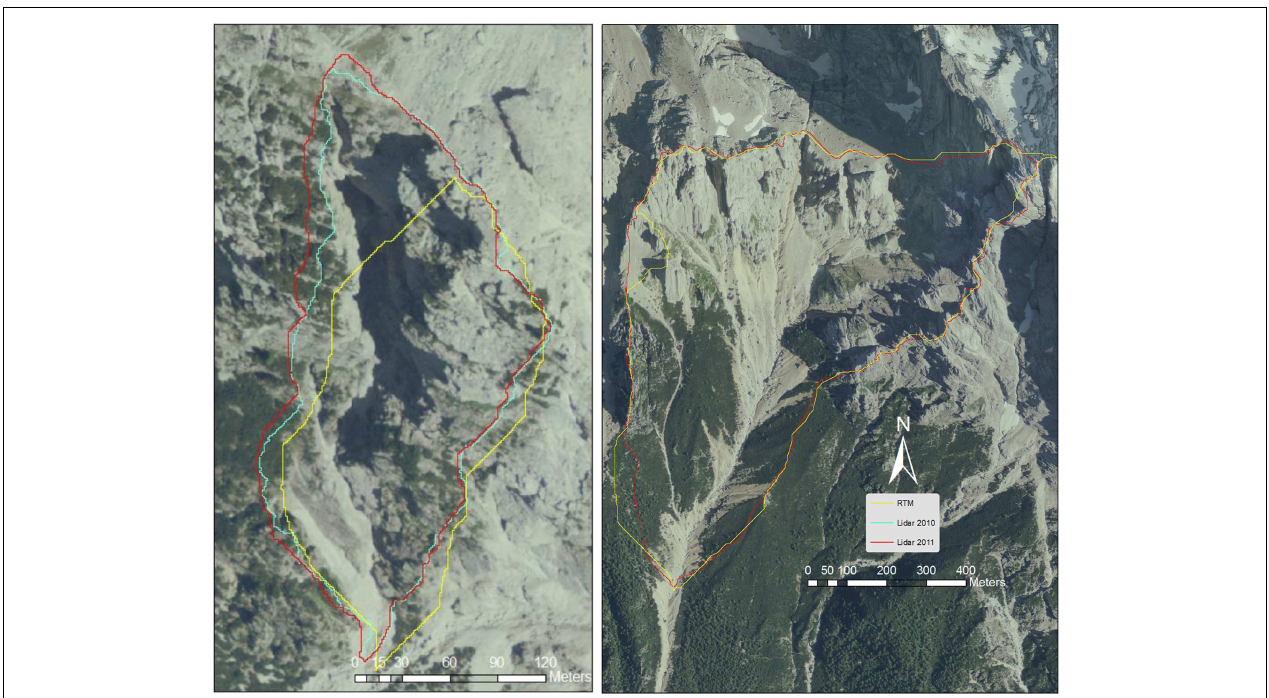
FIGURE 1 | The divides of the two basins of Dimai (left) and Rovina di Cancia (right), obtained by using DEMs derived from different data source (yellow RTM, blue LiDAR 2010, red LiDAR 2011).